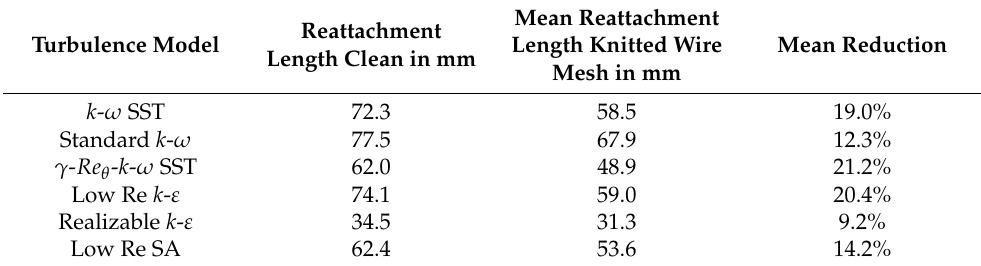
Table 6. Calculated reattachment lengths for different turbulence